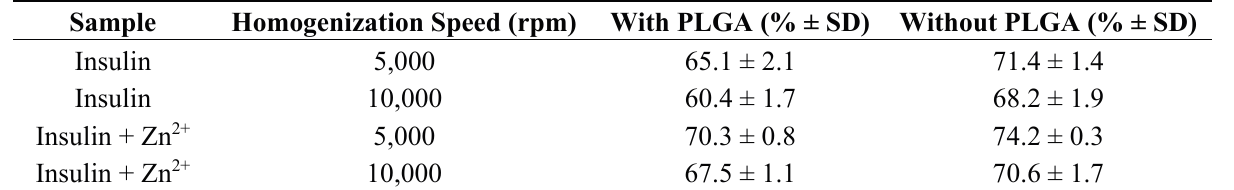
1. Insulin recovered (%) from the primary emulsion with and without poly(lactic- co -glycolic acid) (PLGA) in methylene chloride ( n = 4). Sample Homogenization Speed (rpm) With PLGA (% ±